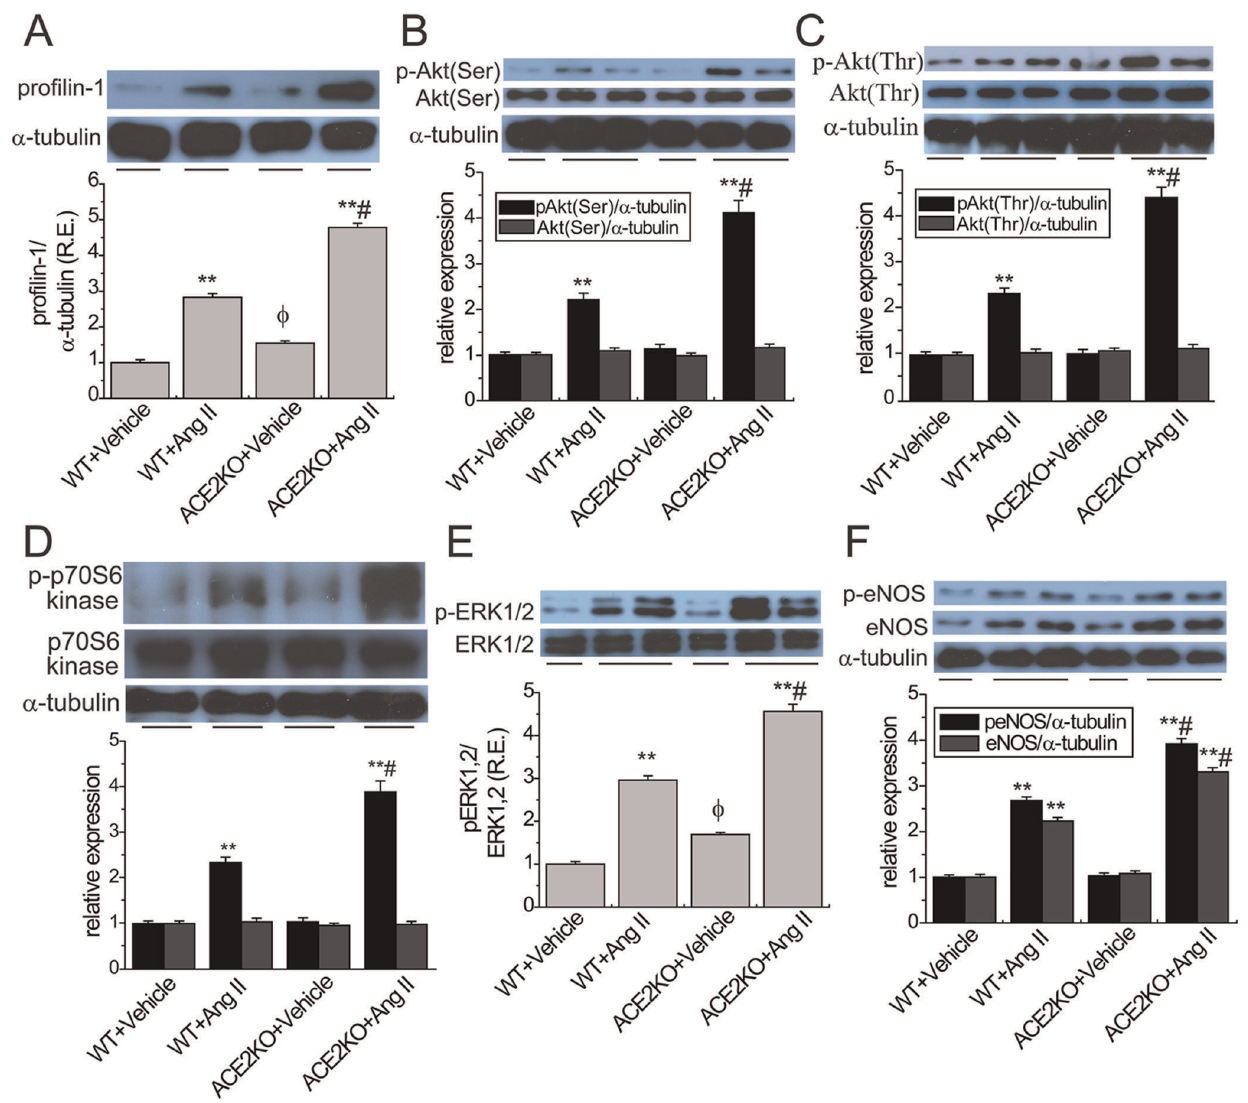
Figure 2. Ang II-mediated aortic profilin-1 expression and activation of signaling cascades in ACE2KO mice. Representative Western blot analysis with quantification exhibited aortic protein expression of profilin-1 (A; 15 kD) and phosphorylated levels of Akt at Ser 473 and Thr 308 (B & C; 60 kD), p70S6K (D; 70 kD), ERK1/2 (E; 44/42 kD) and eNOS (F; 140 kD) in WT and ACE2KO mice in response to Ang II (n=5). R.E.=relative expression; ERK1/2, extracellular receptor-regulated kinases 1/2; eNOS, endothelial nitric oxide synthase. a -tubulin (55 kD) was used as an endogenous control. ** P , 0.01 compared with corresponding vehicle-treated group; # , P , 0.05 compared with WT + Ang II group; w , P , 0.05 compared with WT + Vehicle